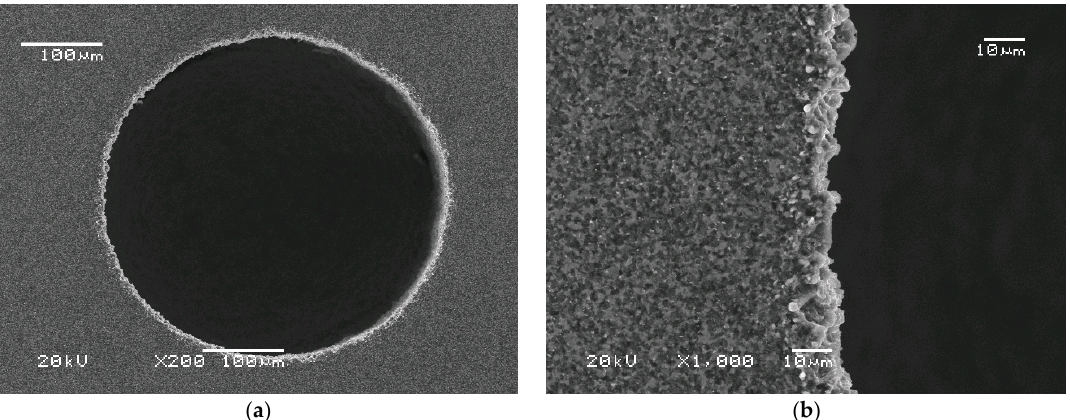
Figure 7. SEM images of hole no.4. U = 120 V, t on = 1 μ s, t off = 1 μ s, threshold current I t = 0.3 A, working current I w = 0.9 A. (a) magnification 200×, (b) magnification 1000×.